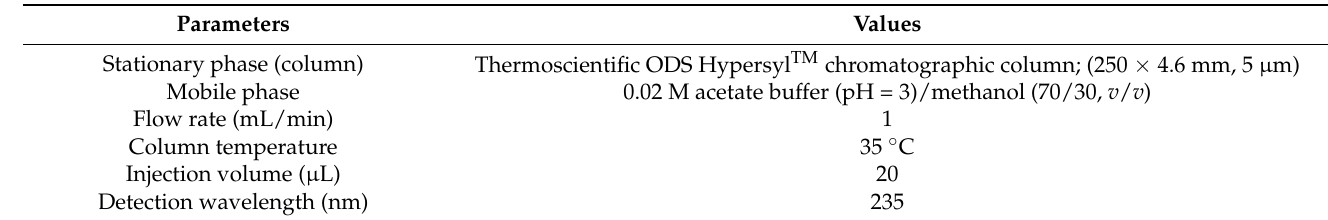
Table 5. Final chromatographic